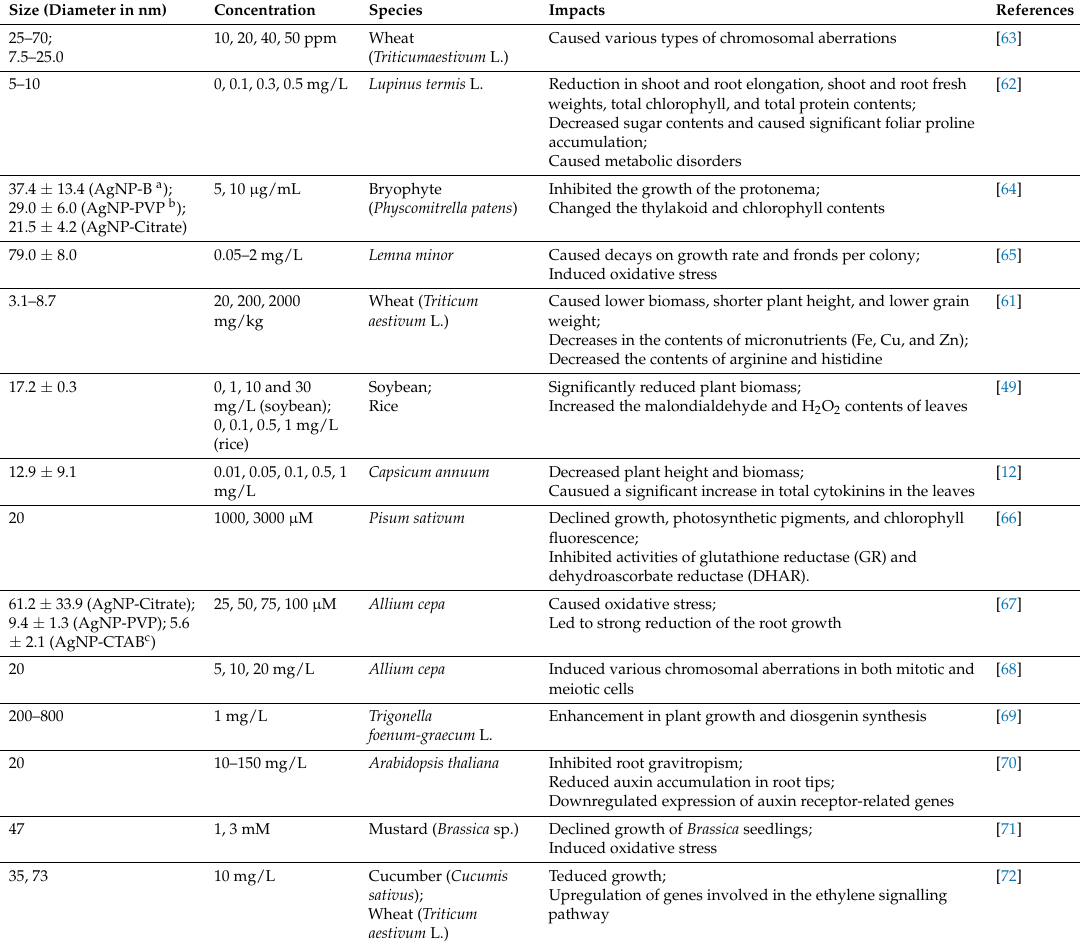
Table 1. Summary of studies on phytotoxicity of silver nanoparticles (AgNPs) in